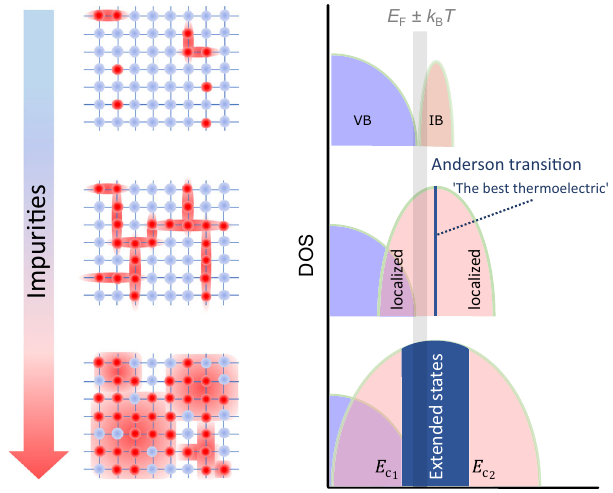
Fig. 1 Sketch of Anderson transition in an impurity band. When the number of randomly distributed impurities in a peridocally ordered crystal increases, the impurity electrons remain localised below a threshold value due to Anderson localisation. At the Anderson transition, the critical density of impurities allows for delocalisation of an in fi nitely narrow energy region of extended states inside the localised impurity states. The delocalised impurity band is marked by two mobility edges E c critical energies that separate the localised from delocalised